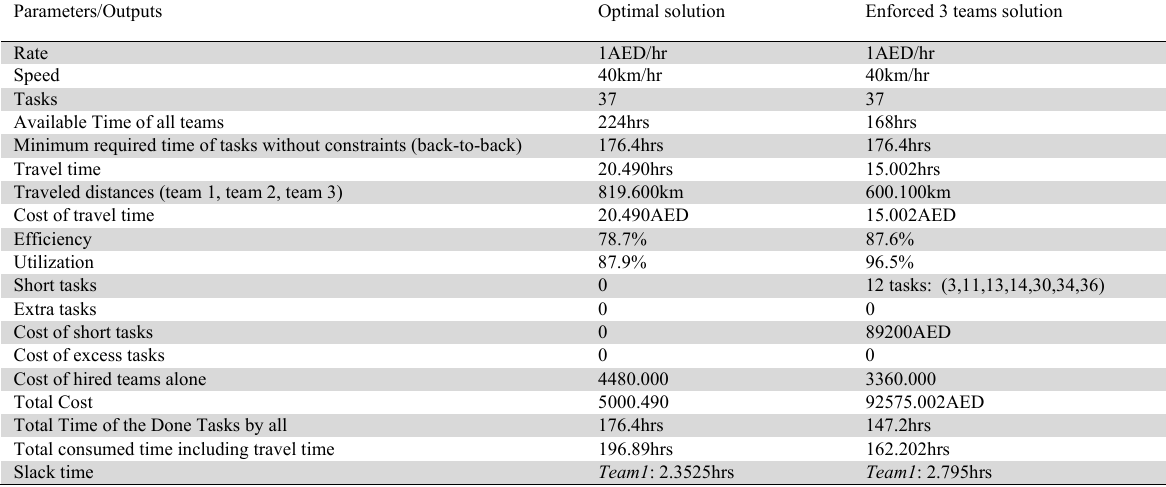
Results of a schedule of 37